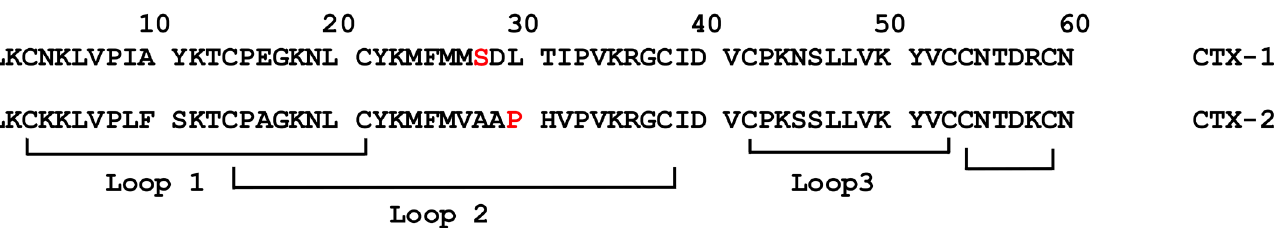
Figure 1. Amino-acid sequences of CTX-1 (UniProtKB accession # P01451 (3SA1_NAJOX)) and CTX-2 (UniProtKB accession # P01441 (3SA2_NAJOX)). Serine 28 (S) and proline 30 (P) residues are shown in